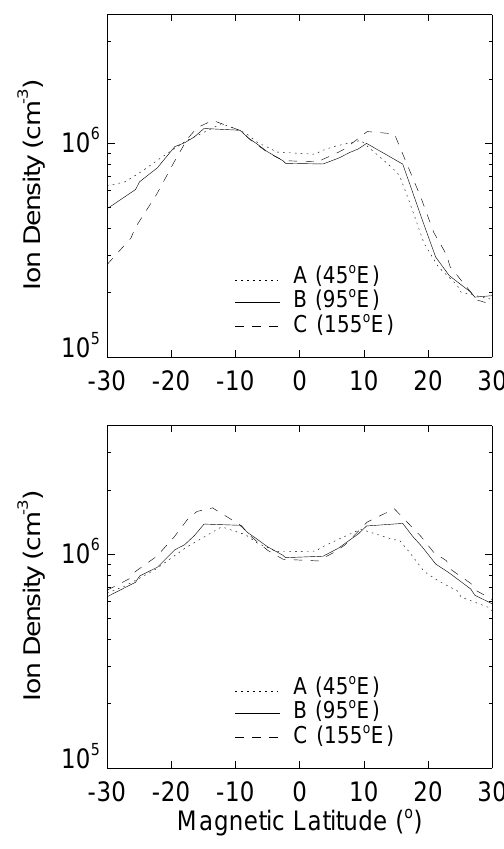
Fig. 3. SAMI2 model plasma density profiles at an altitude of 600km at 12:00–14:00LT on 26 March 2002. The top panel shows the density profiles obtained in the presence of the HWM wind. The bottom panel shows the density profiles obtained after the removal of the HWM